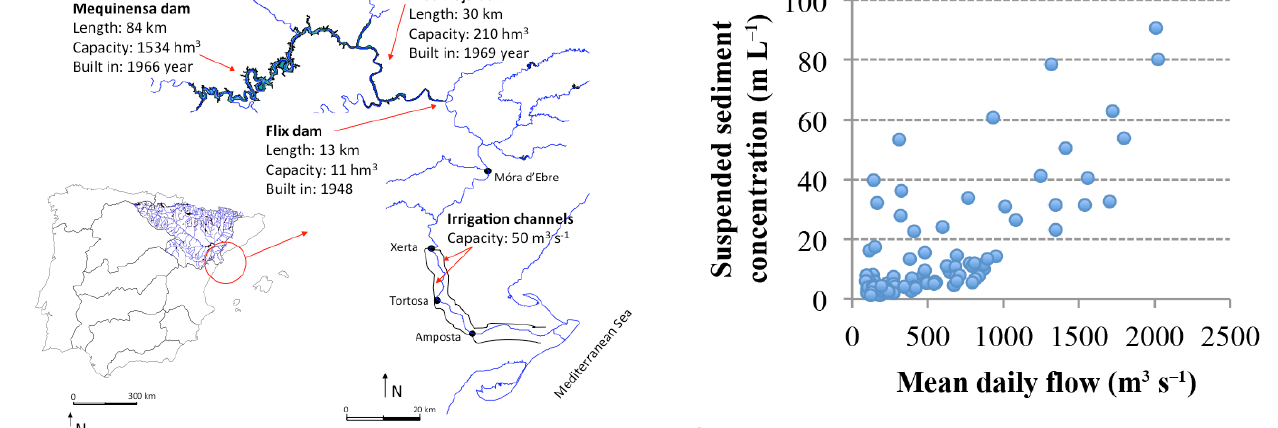
Figure 2. Rating curve of water flow-suspended sediment concen- tration at Tortosa (Fig. 1) in the lower Ebro River, obtained from data during March 2008–December